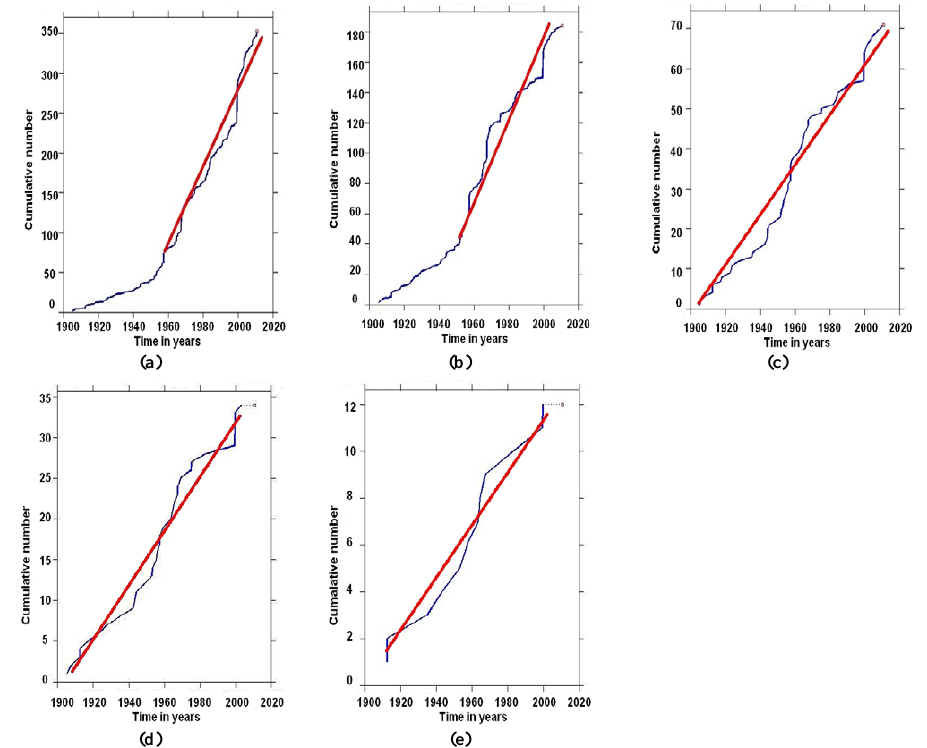
Figure 2. The catalog completeness analysis for the instrumental earthquake catalog showing the cumulative number of events for (a) M w ≥ 4 . 0, (b) M w ≥ 4 . 5, (c) M w ≥ 5 . 0, (d) M w ≥ 5 . 5, and (e) M w ≥ 6 .